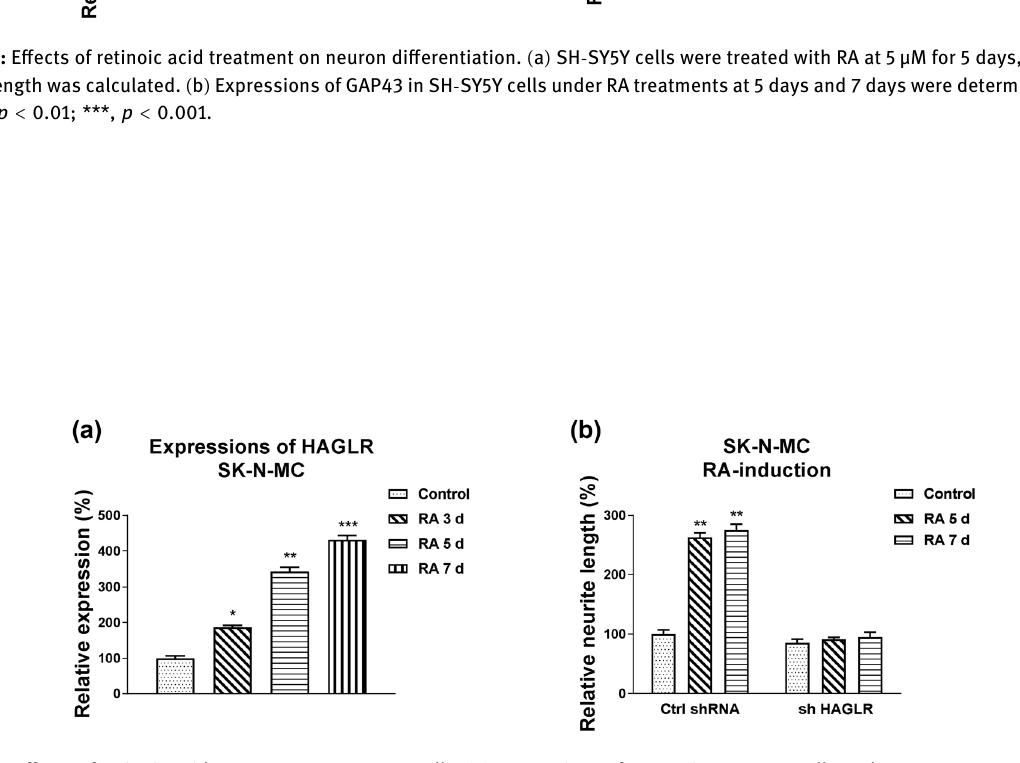
Figure S2: E ff ects of retinoic acid treatment on SK - N - MC cells. ( a ) Expressions of HAGLR in SK - N - MC cells under RA treatments for 3, 5 and 7 days were determined by qRT - PCR. ( b ) The relative neurite length was calculated in SK - N - MC cells without or with HAGLR silencing under RA treatments for 5 and 7 days. *, p < 0.05; **, p < 0.01; ***, p <